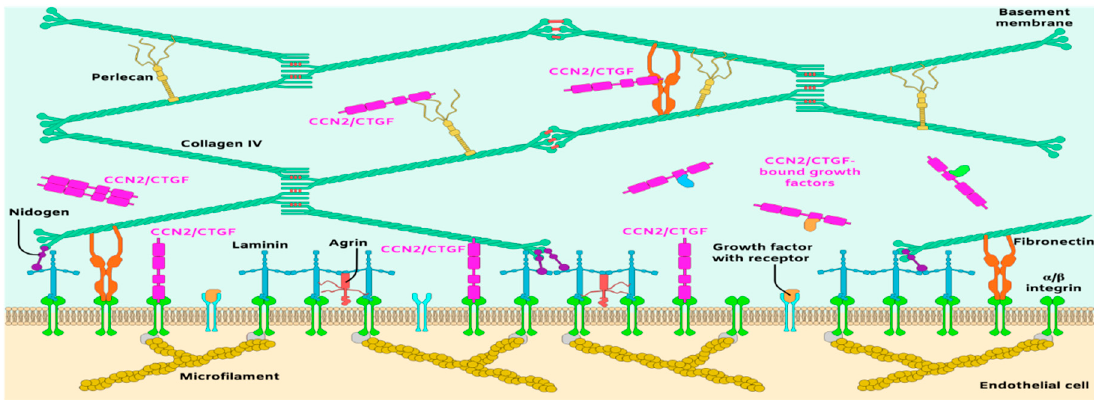
Figure 2. Schematic representation of the principal molecular components of the subendothelial matrix and basement membrane of blood vessels.